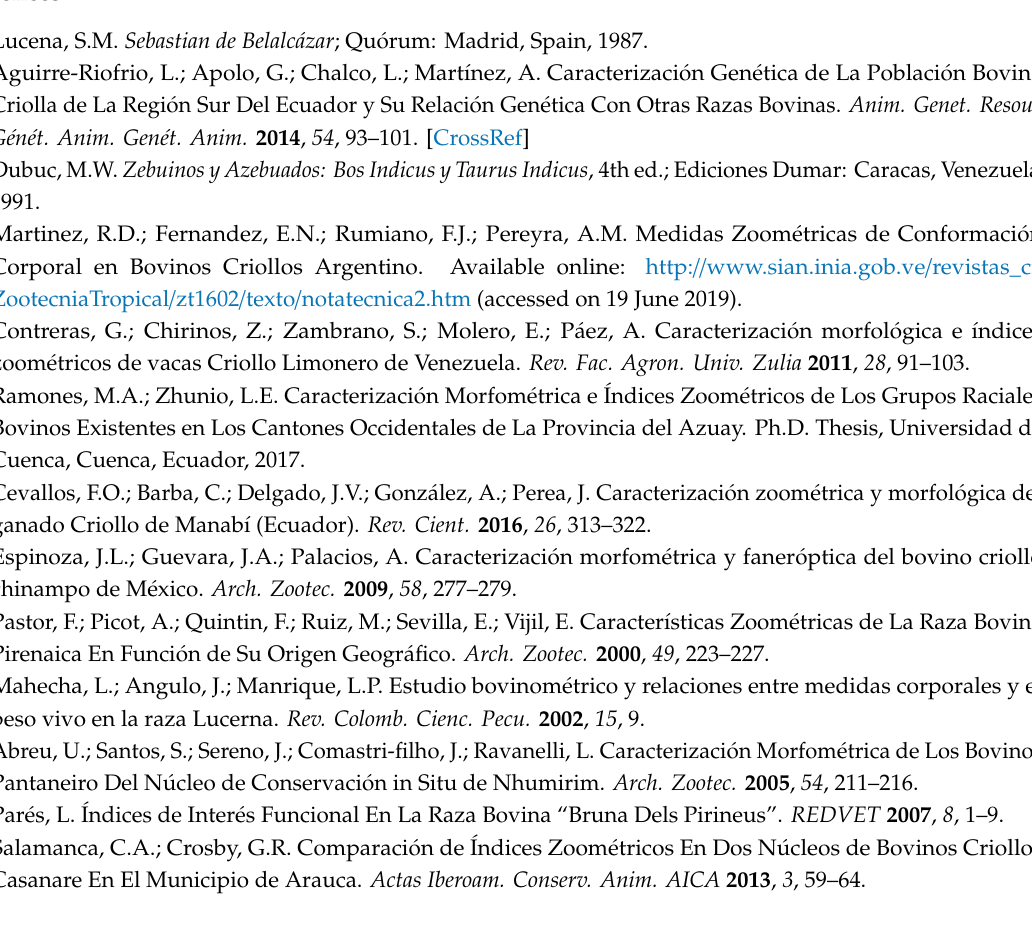
Table S1: Least Squared Means and Mean di ff erence of Morphometric characteristics from bovine creole of Southern Ecuador for the biotype and